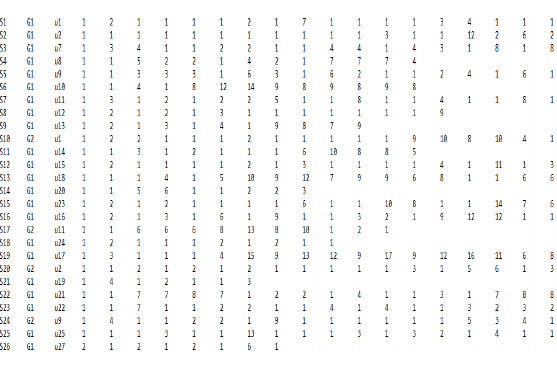
Figure 9. XML File 1